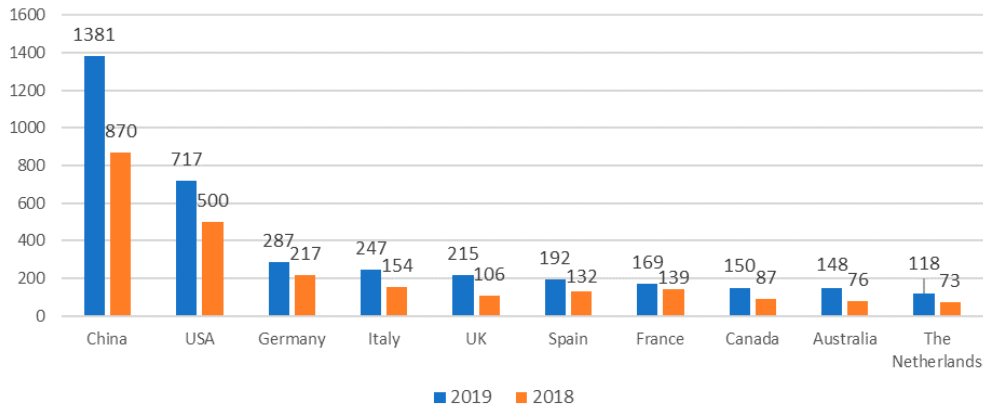
Figure 4. Top 10 countries / territories based on the percentage of author distribution in 2018 vs. 2019 for the Remote Sensing Open Access Journal of MDPI.